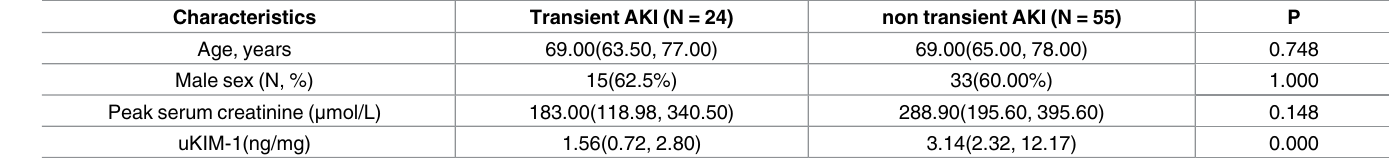
Table 3. Comparison between the transient AKI group and the non transient AKI group among elderly patients with AKI. Characteristics